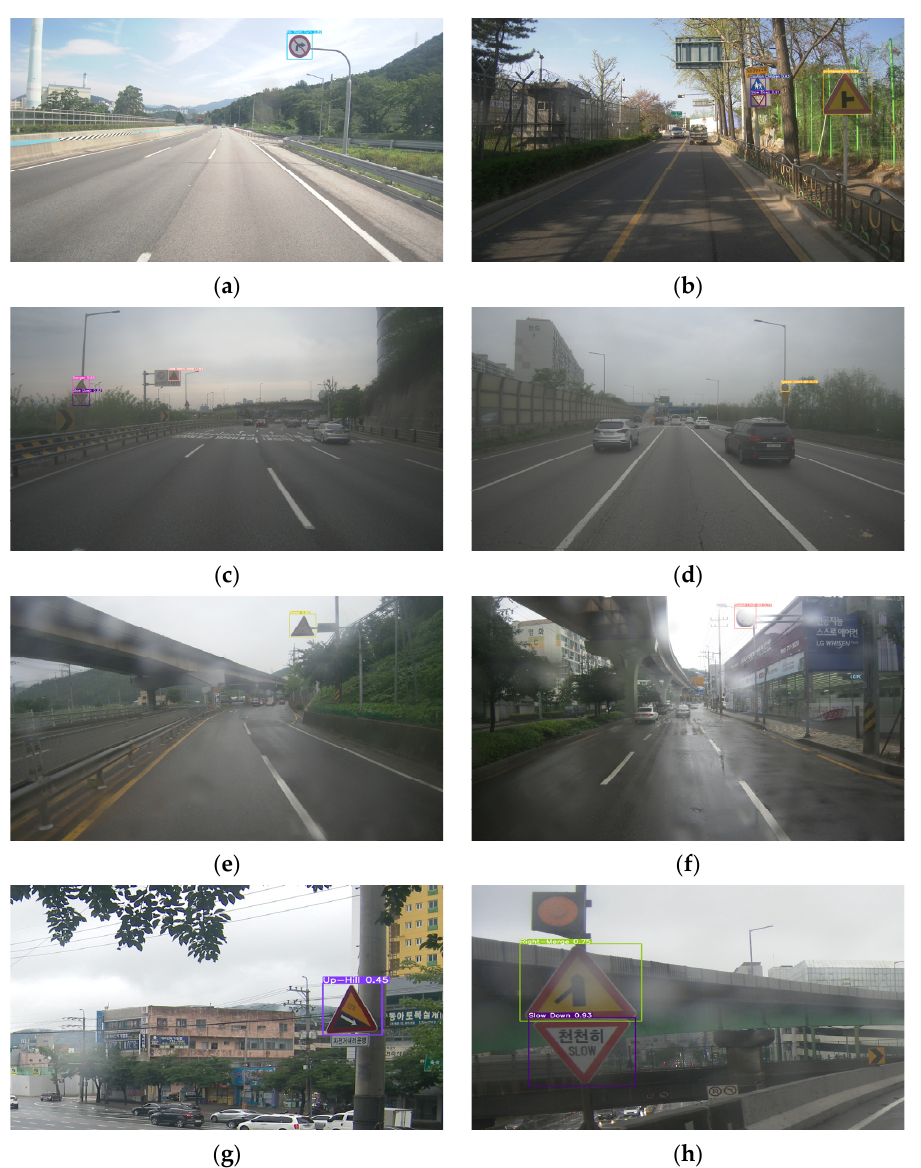
Figure 5. Examples of traffic sign recognition results in different weather conditions: ( a ) Clean (0.89), ( b ) Clean (0.84), ( c ) Cloud (0.63), ( d ) Cloud (0.72), ( e ) Rain (0.82), ( f ) Rain (0.77), ( g ) Cloud (0.45), and ( h ) Rain (0.75). Note that the numbers in the brackets indicate the minimum confidence score for the accurately recognized traffic signs in the examples.